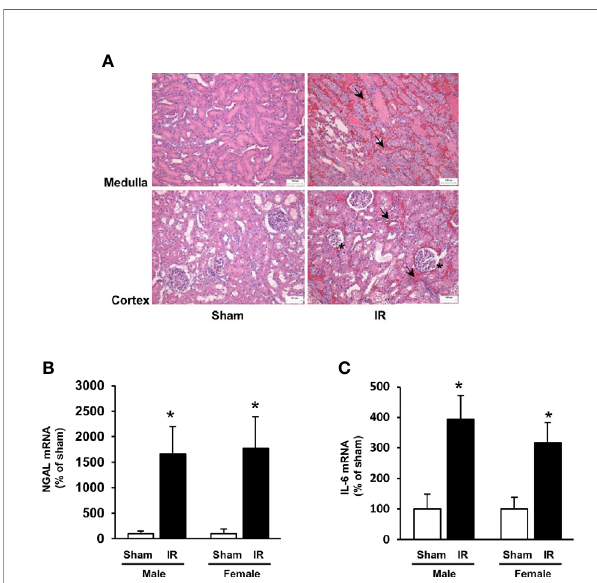
FIGURE 2 | Kidney histology and expression of NGAL and IL-6. Rats were subjected to kidney ischemia-reperfusion (IR) or sham operation (sham). (A) Representative hematoxylin and eosin (H&E) staining images of kidney sections are shown (magni fi cation x200). Arrows and stars point the area having red blood cell accumulation and irregular glomerular structures, respectively. The bar on the images represents 100 m m. The mRNA of NGAL (B) and IL-6 (C) was measured by real-time PCR analysis. Results are expressed as mean ± SE (n = 6). * P < 0.05 when compared with the value obtained from the sham- operated group.